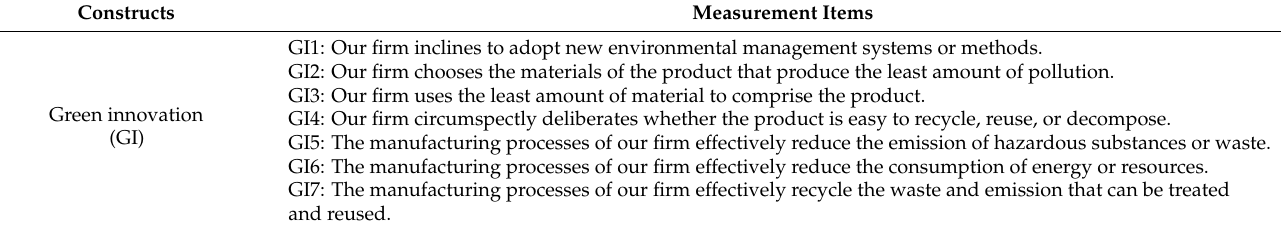
Table A2. Measurement